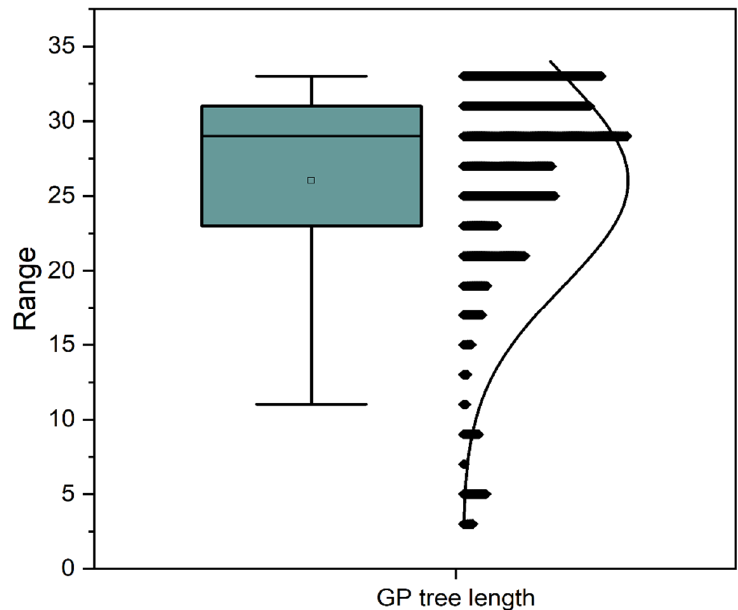
Processes 2021 , 14 , x FOR PEER REVIEW Figure 5. Typical variation in GP tree lengths of an entire population for any given generation.